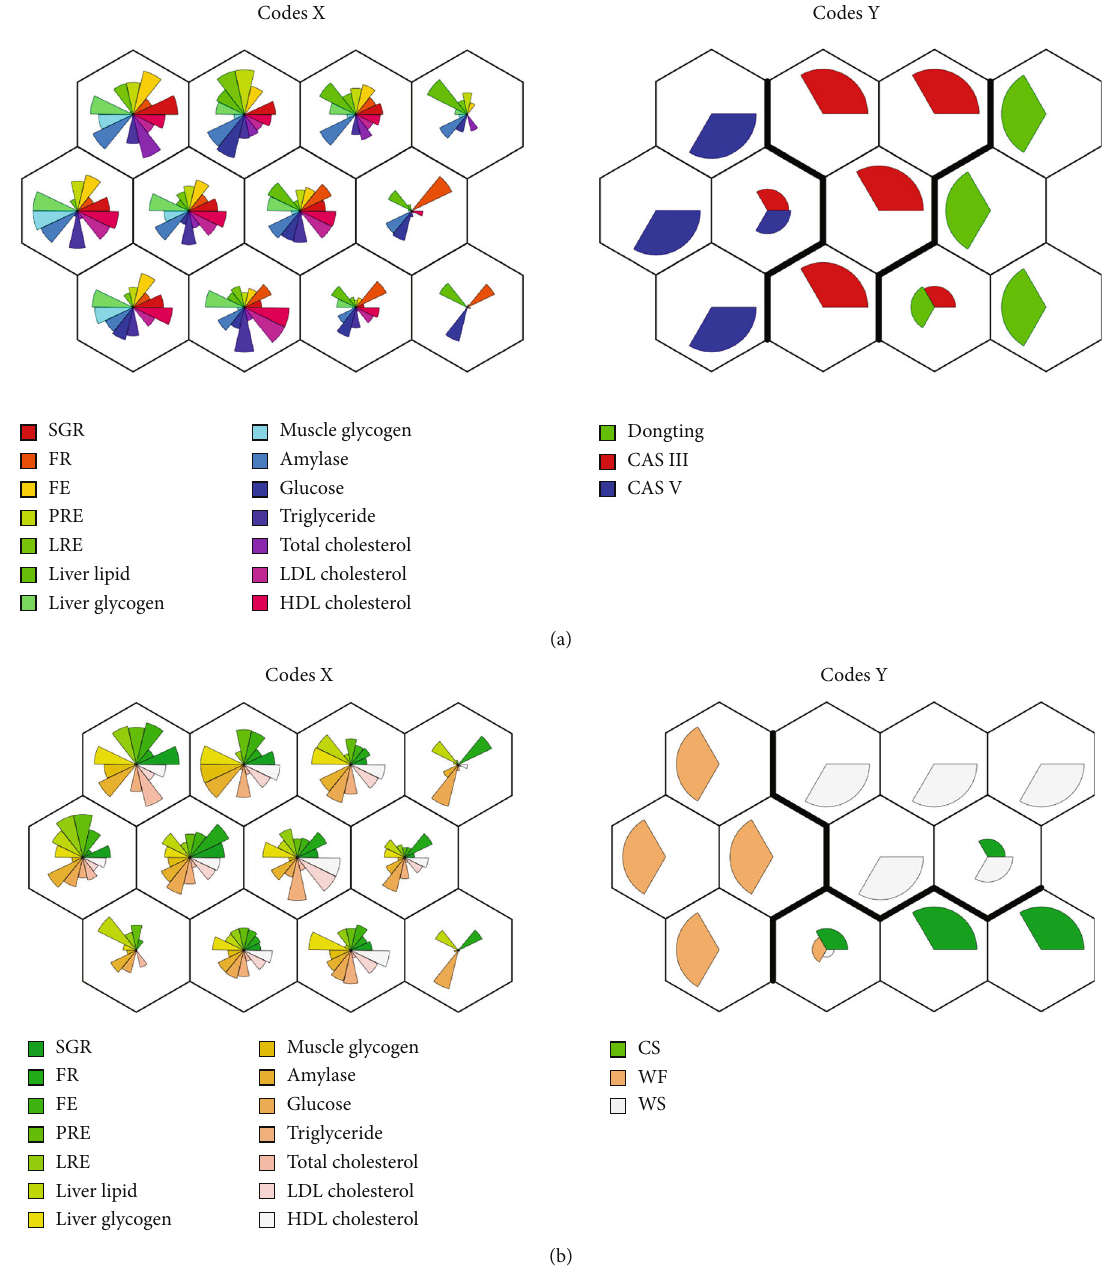
Figure 1: Plots of the codebook vectors of the 4-by-3 mapping for the key variables of the physiological responses from three strains of gibel carp fed di ff erent dietary carbohydrate sources using the self-organizing map (SOM). (a) The variables from 27 samples distributed by strain categories. (b) The same variables distributed by carbohydrate source categories. Code X : each fan in the neuron represents a variable with di ff erent colours, and the weight of a fan corresponds to the magnitude of variable values in a particular dimension. Code Y : each treatment position predicted by the characteristic cluster of